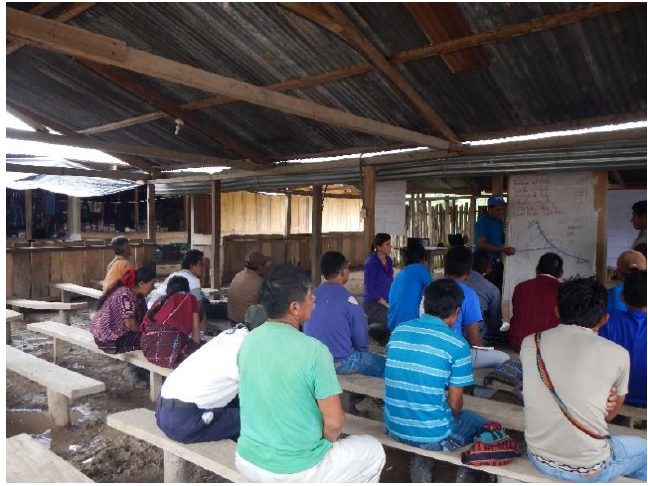
Figure 3. One of the collaborative workshops with dam-threatened Q’eqchi’ communities (credit Lieselotte Viaene, 2014).